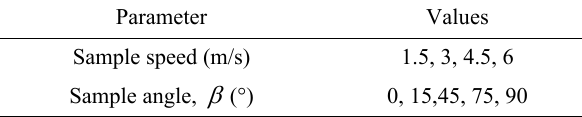
Table 3 Range of variables for studying the flow